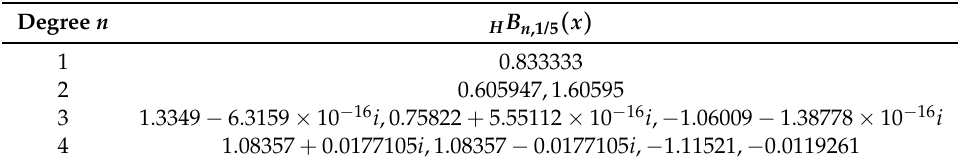
Table A2. Zeros of H B n ,1/5 ( x )